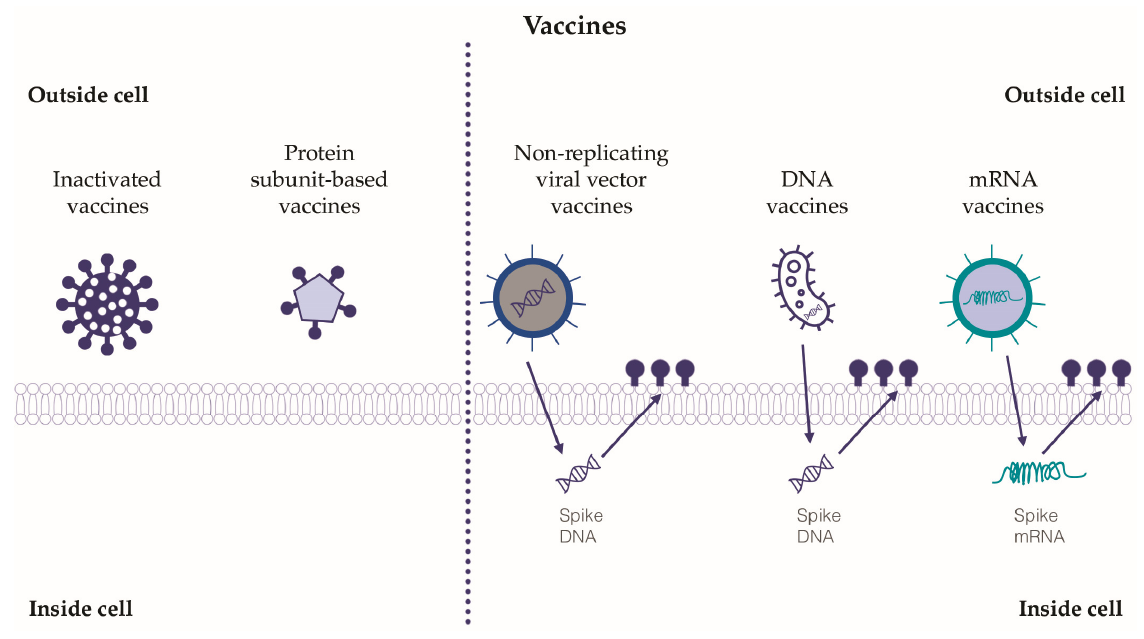
Figure 3. The relevant classes of tested vaccines against SARS-CoV-2. Five classes of vaccines against SARS-CoV-2 have been tested, and some have been approved for use in humans. Inactivated vac- cines and protein subunit-based vaccines exert their action outside the target cells, whereas non- replicating viral vector vaccines, DNA and mRNA vaccines need to act inside the target cells in order to adopt the cellular transcription and translation systems. The immune response and immun- ization induced by viral vector vaccines, DNA and mRNA vaccines seem to be more relevant than those induced by inactivated and protein subunit-based vaccines.